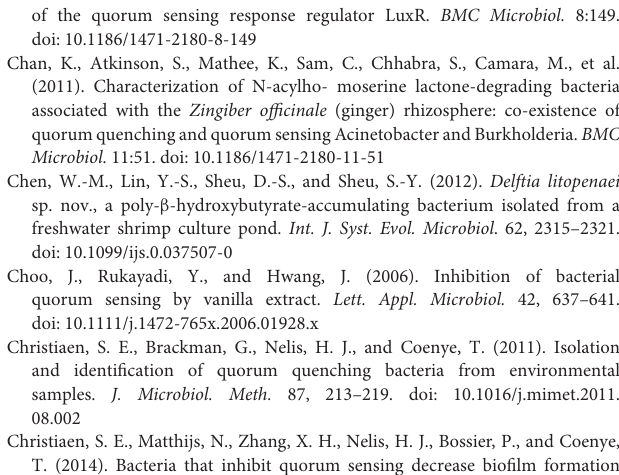
Figure S1 | Antibacterial disc diffusion assay of D. tsuruhatensis SJ01 against C. violaceum CV026. The Mueller-Hinton agar (MHA) plate containing reference strain C. violaceum CV026 were tested for antibacterial activity of D. tsuruhatensis SJ01. Strain SJ01 represents the culture (5 µ l) and the antibiotic tobramycin (5 µ l) was used as a positive control. Figure S2 | Phylogenetic position of D. tsuruhatensis SJ01 (KX130769) with taxonomic neighbors. Numbers at nodes are percentage bootstrap values. The phylogenetic tress was computed using the maximum composite likelihood method and are in the units of the number of base substitutions per site. All positions containing gaps and missing data were eliminated by the complete deletion option. Phylogenetic analysis was conducted in MEGA (ver 6). Bar indicates 0.005 substitutions per nucleotide position. Figure S3 | Whole cell fatty acid profiling of the bacterium D. tsuruhatensis SJ01. The whole cell fatty acid profile of strain SJ01 was performed by GC coupled with MIDI. The name of the fatty acids was assigned on the basis of corresponding fatty acids of RTSBA6 6.10 library match. Figure S4 | Effect of extract of D. tsuruhatensis SJ01 extract on planktonic cell growth of P. aeruginosa . Different concentration of bacterial extracts (SJ01; 0.01 − 0.1 mg/ml) was tested against biofilm forming reference strain P. aeruginosa PAO1 and pathogenic strain P. aeruginosa PAH. Tests without extract and with methanol were considered as control and negative control, respectively. Figure S5 | Effect of extract (0.1 mg/ml) of D. tsuruhatensis SJ01 extract on the growth curve of P. aeruginosa . Bacterial extracts (SJ01; 0.1 mg/ml) was tested for effect on growth of biofilm forming reference strain P. aeruginosa PAO1 and pathogenic strain P. aeruginosa PAH. The OD was taken up to 24 h at 600 nm using spectrophotometer. Growth of bacteria without treatment of extract (SJ01) was considered control. Figure S6 | Antibacterial disc diffusion assay of D. tsuruhatensis SJ01 against P. aeruginosa . Clinical isolates of P. aeruginosa PAO1 and PAH were tested for antibacterial activity of D. tsuruhatensis SJ01 extract. The bacterial extract did not show any antibacterial activity against the clinical isolates P. aeruginosa . Figure S7 | A microarray scattered plot showing differential expression of genes. Up- and down- regulation of genes are indicated by blue and green colored marks, respectively. The analysis was performed in expression console and transcriptome analysis console, and genes exhibiting significant fold expression (ANOVA p < 0.05) were considered for the study. Table S1 | Total transcripts that differentially expressed (up- or down- regulated) in P. aeruginosa PAO1, treated with bacterial ( D. tsuruhatensis SJ01) active